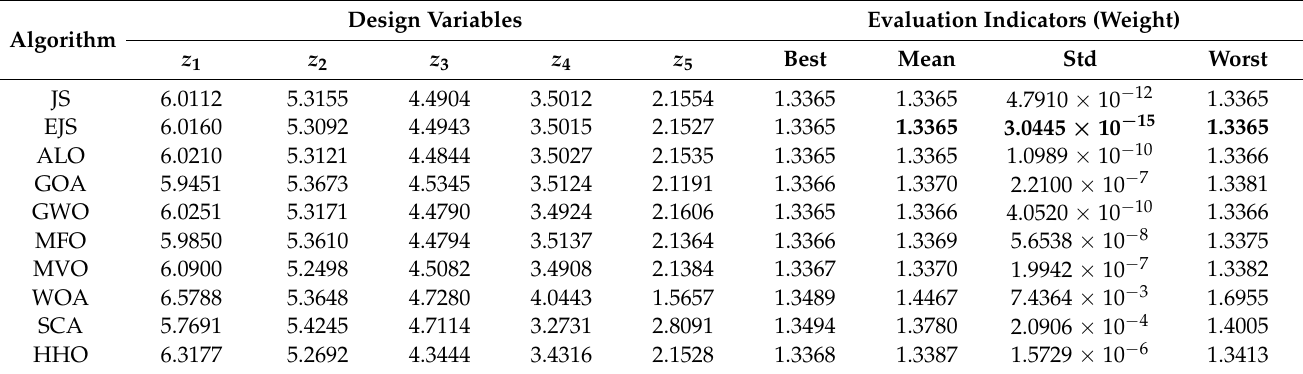
Table 9. Evaluation indicators and variable values for Figure